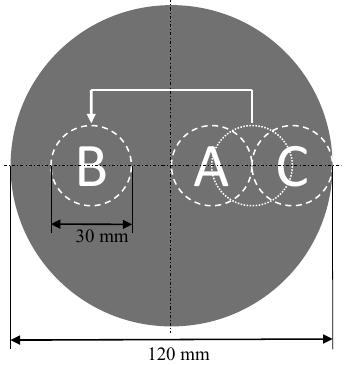
Figure 7. Disc segments for fiber length analysis.